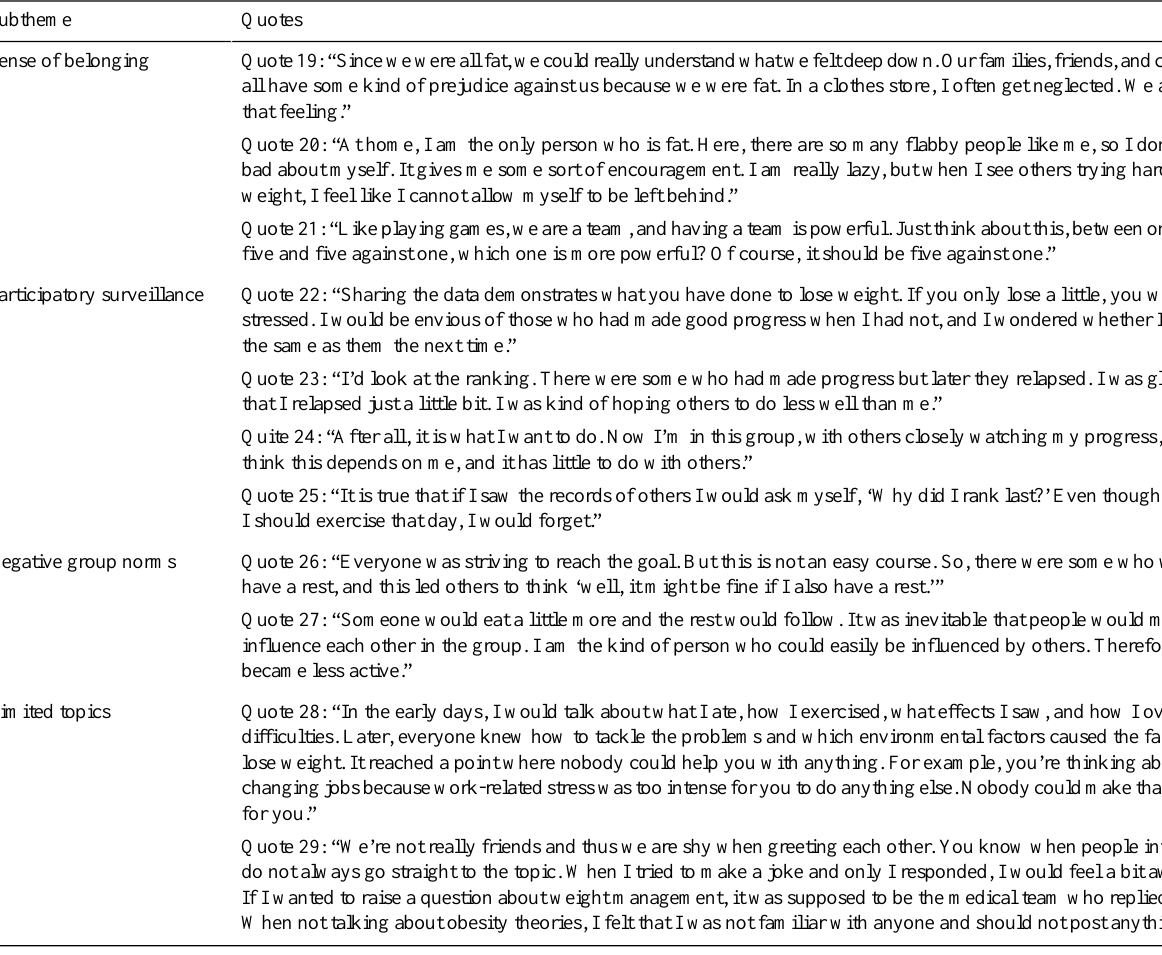
Table 3. Supporting quotes for theme 3: Mutual reinforcement of peer influences.